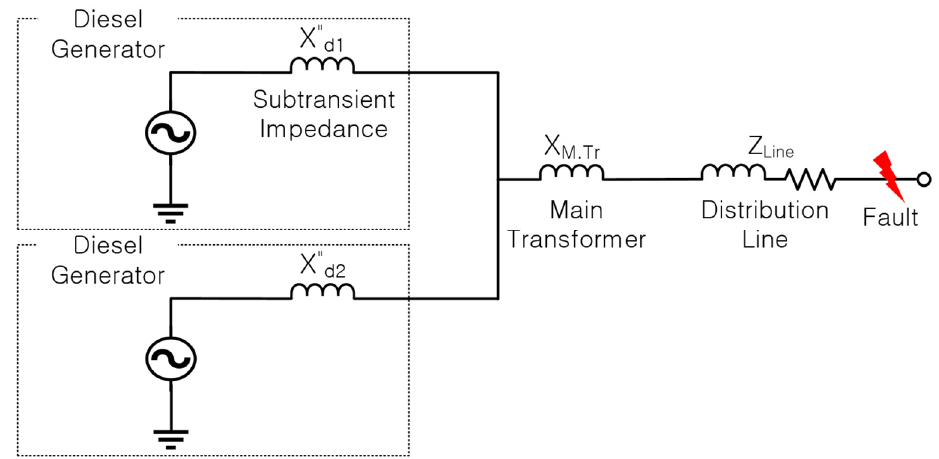
Figure 5. Equivalent circuit for fault current calculation of diesel generators.